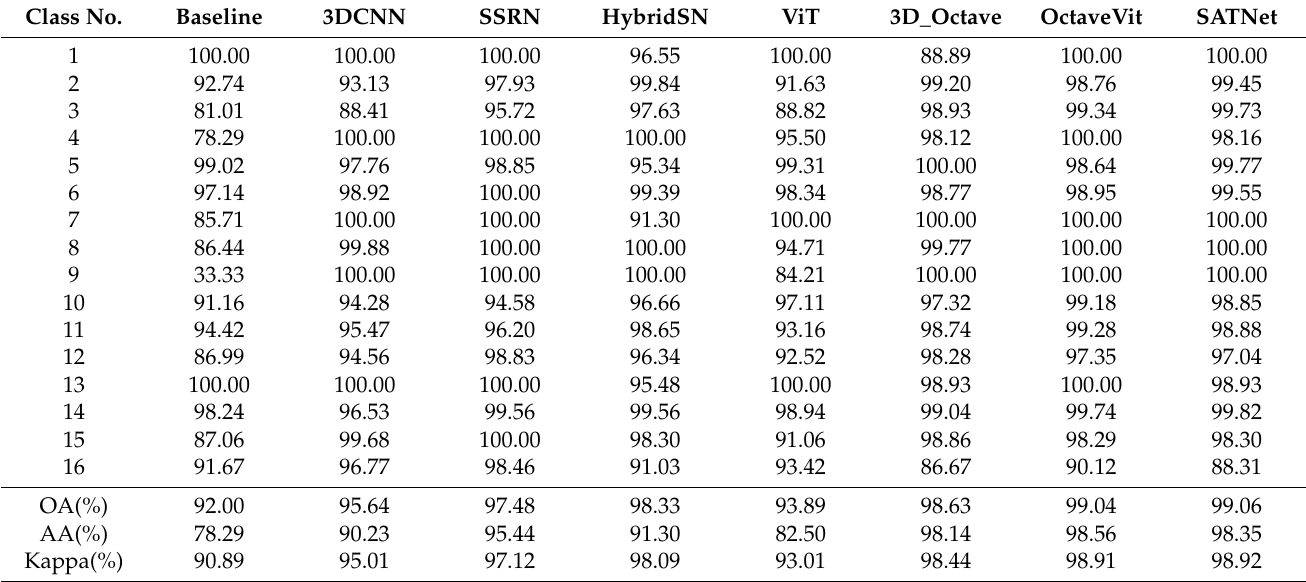
Table 6. Test accuracy with different preprocessing methods on the IP